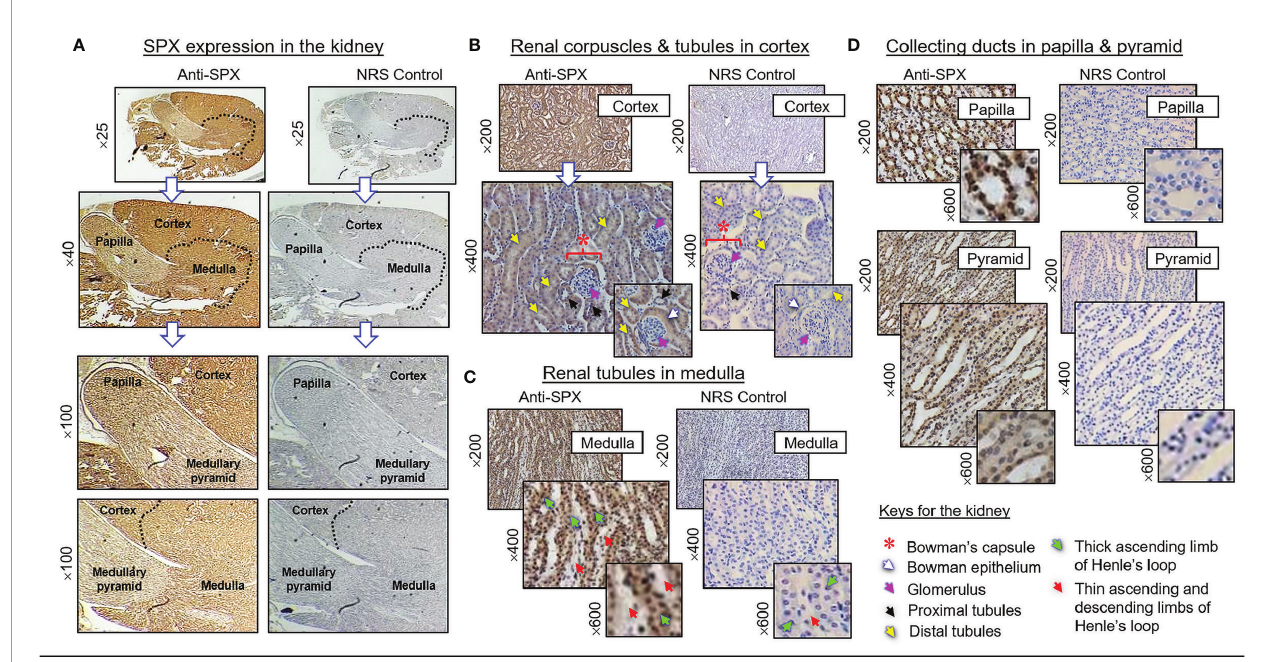
FIGURE 6 | Histological distribution of SPX expression in the kidney. (A) SPX immunoreactivity detected by anti-SPX in different regions of the mouse kidney, including the papilla, medullary pyramid, inner medulla and outer cortex. (B) SPX expression in the outer cortex. SPX signals could be identi fi ed in Bowman epithelium (but not in glomerulus) of renal corpuscles as well as in the wall of both proximal and distal tubules. (C) SPX expression in the medulla. SPX signals were found in the wall of thick ascending limb but not in thin ascending/descending limbs of Henle ’ s loop. (D) SPX expression in the papilla and medullary pyramid. Speci fi c signals of SPX could be noted in the wall of collecting ducts within the papilla and pyramid regions. Parallel staining with NRS was used as the negative control and the numbers shown on the side of individual panels (×25, ×40, ×100, ×200, ×400, and ×600) represent the level of magni fi cation for the respective pictures.